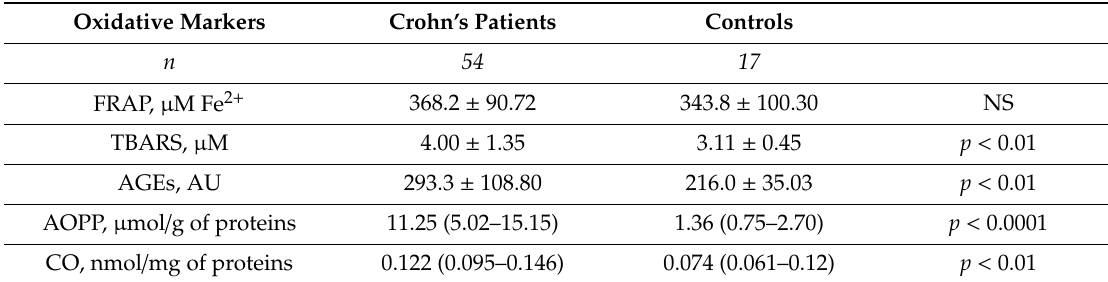
Table2. MeanvaluesofoxidativemarkersinserumsamplesfromCrohn’spatientsorhealthyvolunteers.